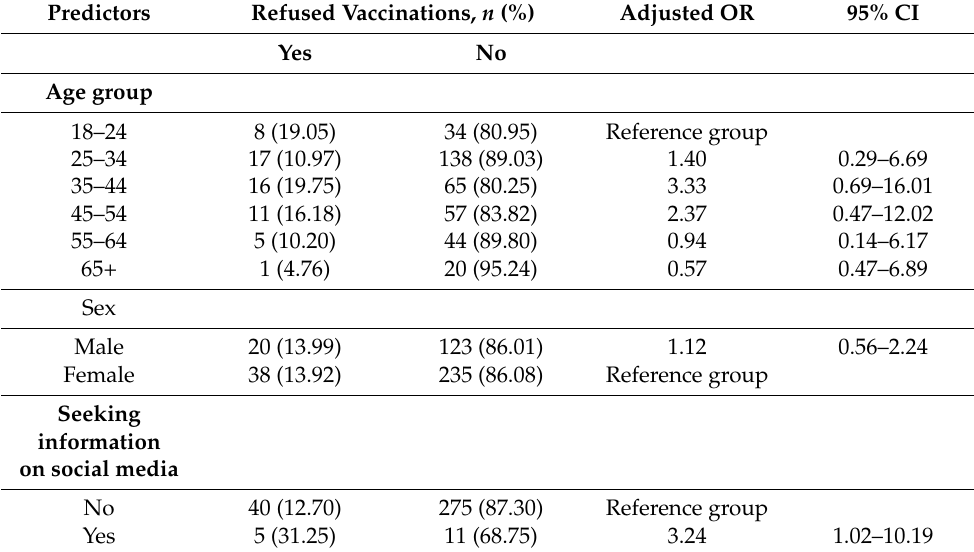
Table 6. Multivariate logistic regression analysis: predictors of refusing pretravel